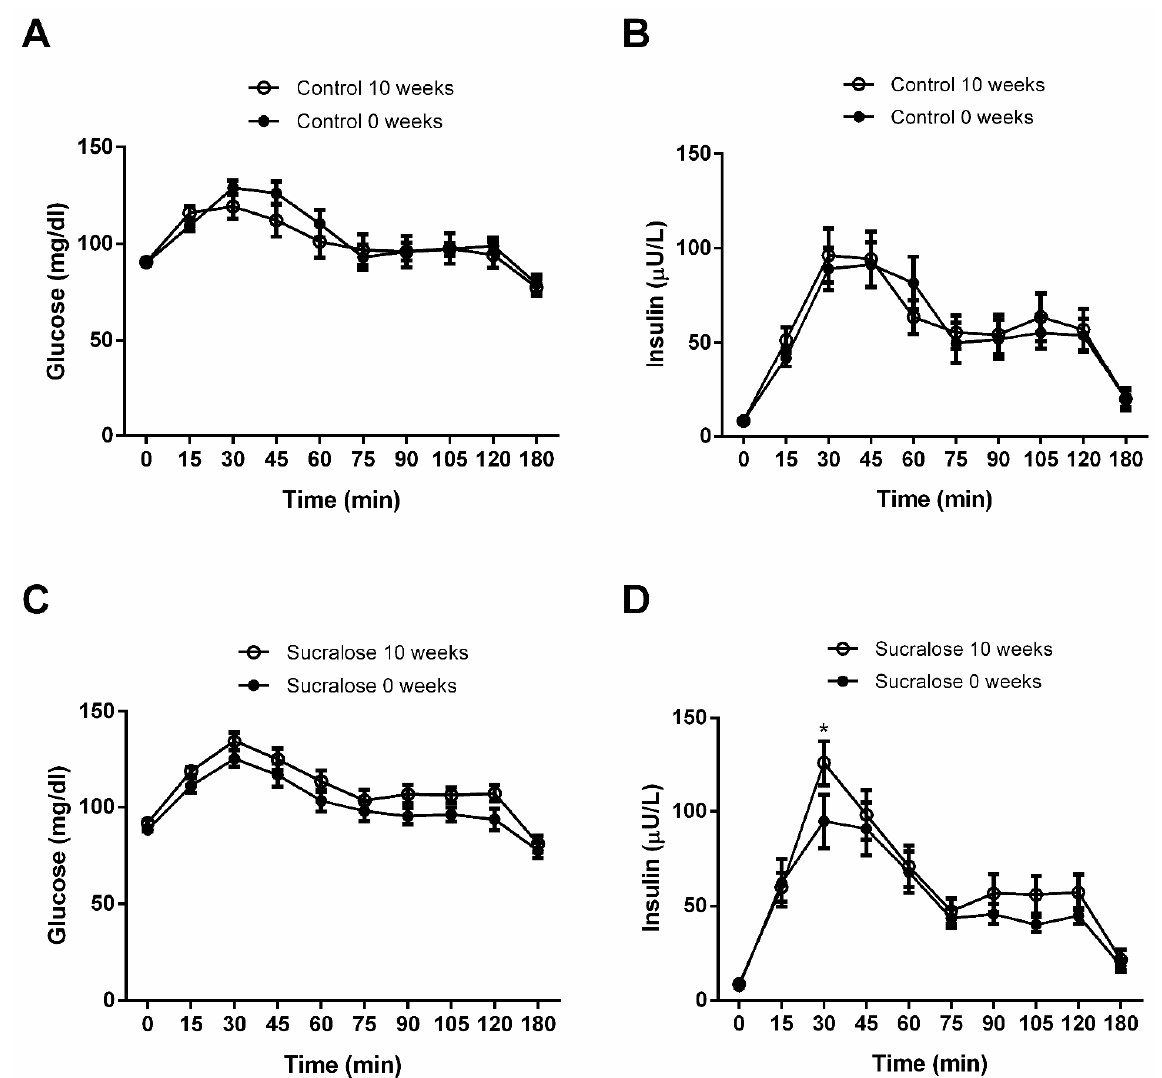
Figure 2. Blood levels of glucose and insulin during oral glucose tolerance test. ( A ) Volunteers receiving water for ten weeks showed no differences in blood glucose curves compared to the beginning of the study (0 weeks). ( B ) Participants receiving water for ten weeks exhibited no differences in serum insulin curves compared to the beginning of the study. ( C ) Volunteers drinking sucralose for ten weeks showed no differences in blood glucose curves compared to the beginning of the study. ( D ) Participants consuming sucralose for ten weeks exhibited a significant increase in serum insulin, with the maximum peak occurring 30 min after glucose load, compared to that found at the beginning of the study. We show control and sucralose groups at 0 weeks in closed circles, whereas both groups are shown in open circles at ten weeks. We express data as mean ± standard deviation. We estimated significant differences by two-tailed 2-way ANOVA with Bonferroni correction. Asterisks (*) indicate significant differences when p < 0.05.